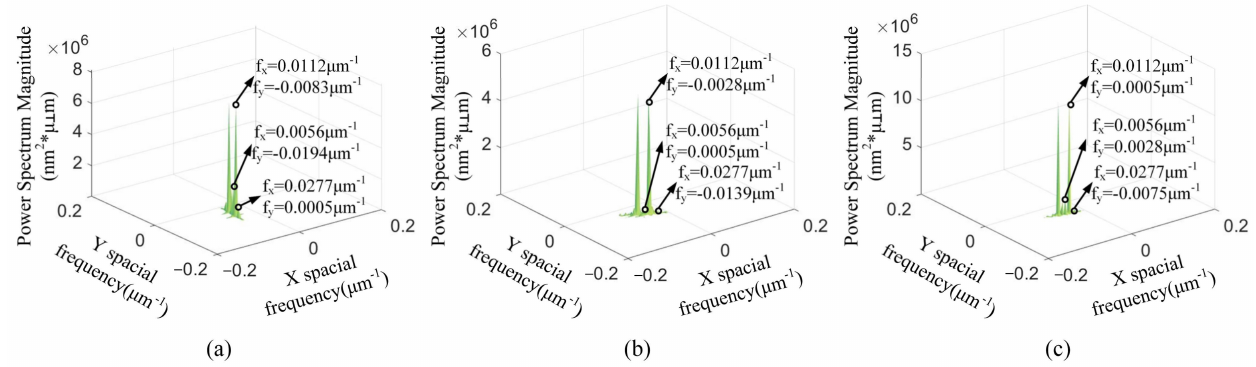
Figure 6. The 2D PSD results with different spindle speeds: ( a ) n = 1300 r/min, ( b ) n = 1400 r/min, ( c ) n = 1500 r/min.